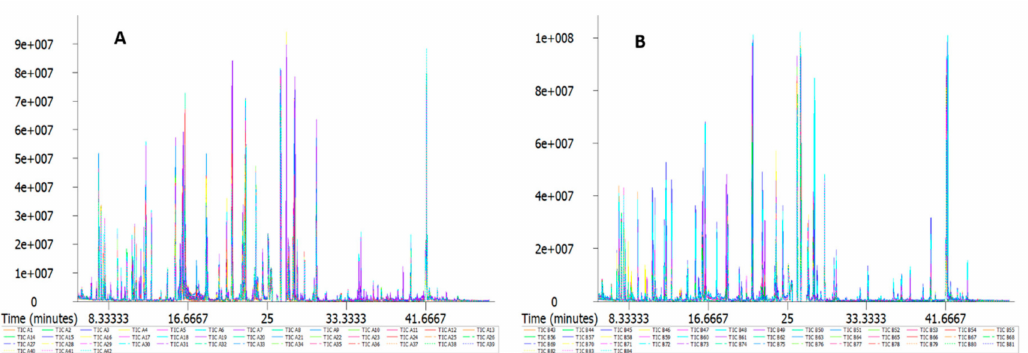
Figure 3. ( A ) (strain 18) and ( B ) (strain 18N44) samples were aligned with the original peak of total ion current; seven repeated samples were taken for each